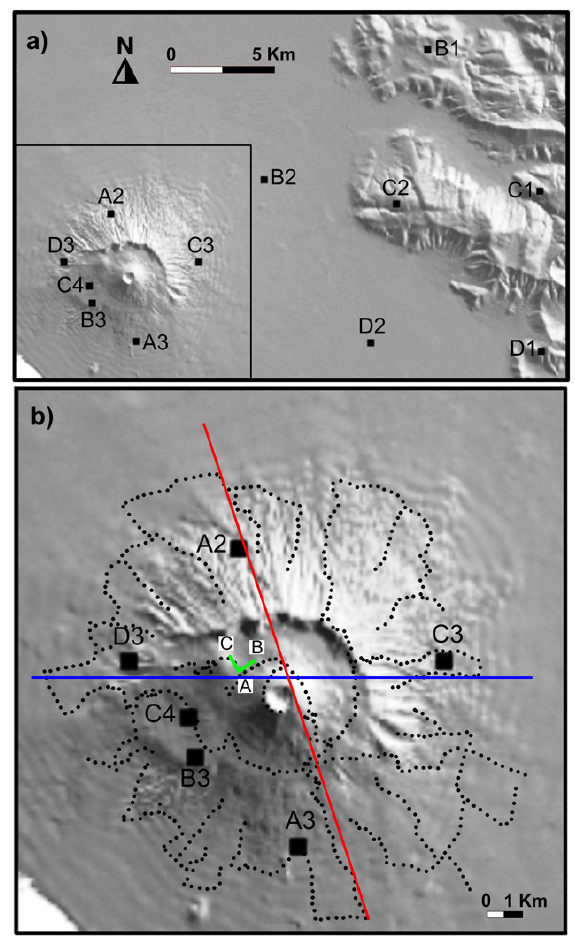
Figure 1. (a) Map showing the distribution of the shot points (black rectangles) used for the seismic tomography survey at Somma-Vesu- vius (Naples, Italy). (b) Location of the AB and AC dipoles (green lines) along which the natural electric field was measured. The black points indicate the SP measurement circuits, and the red and blue lines define the resistivity tomography profiles (see text) [Di Maio et al.